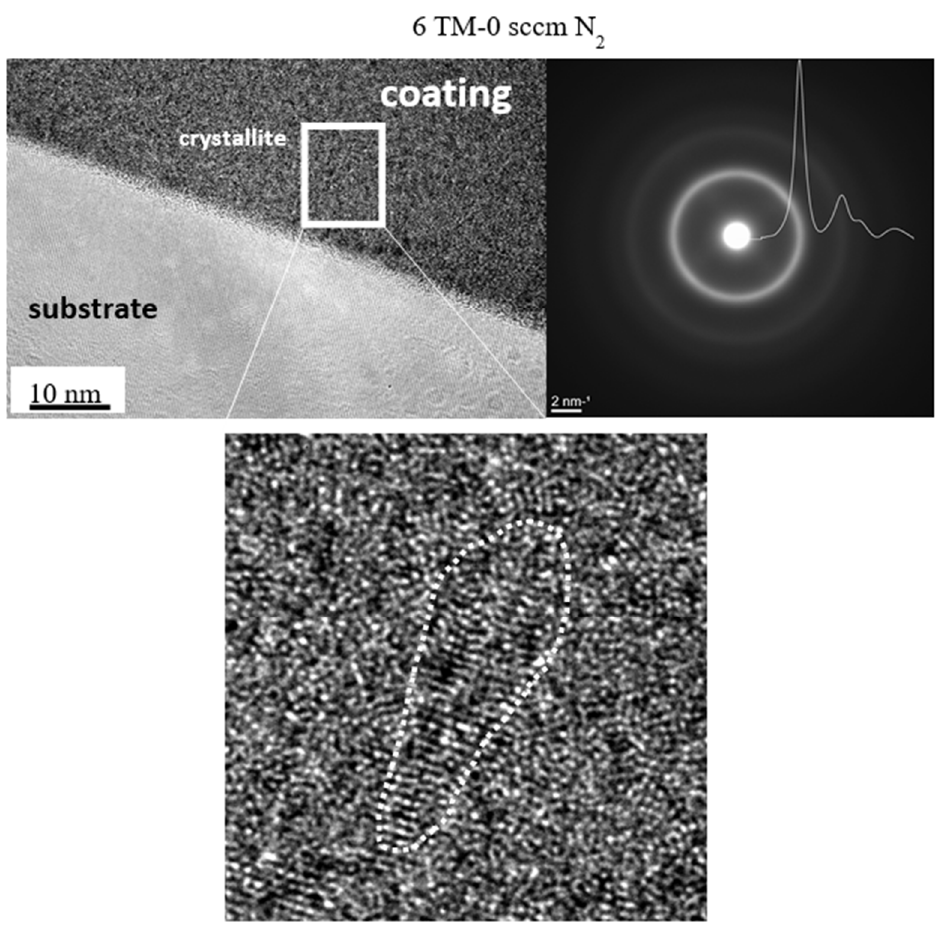
Figure 4. Structure of HiTUS TiNbVTaZrHf coatings deposited without nitrogen additions. SAED spectrum indicates an amorphous structure despite the occasional presence of small crystallites de- tected by HRTEM (see insert). Azimuthal integral SAED also corresponds to an amorphous structure.